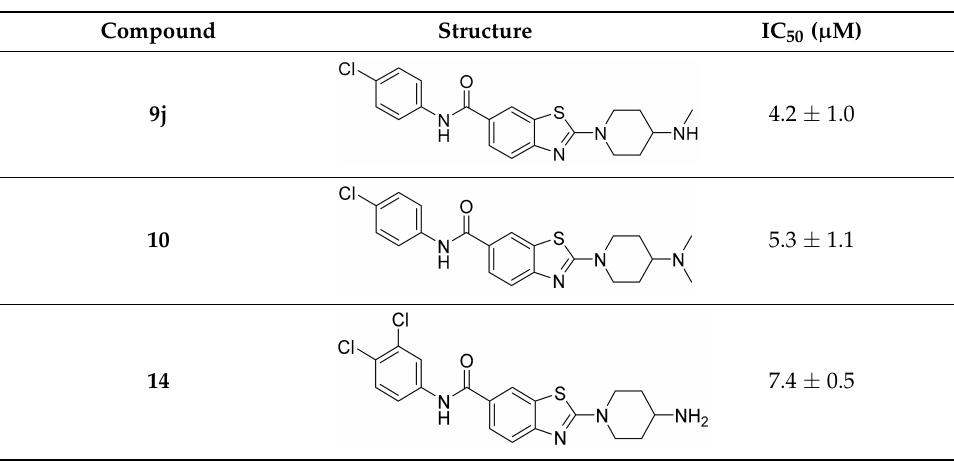
Table 3. IC 50 values for the antiproliferative activities of the 9i analogs evaluated in the MCF-7 breast cancer cell line.